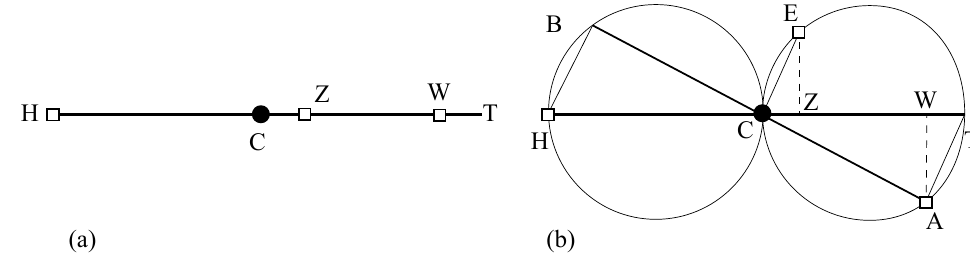
Figure 5. Equilibrium of a beam under three weights: ( a ) a modern interpretation; ( b ) appealing to the law of the lever; ( b ) is redrawn from [19], p. 222.